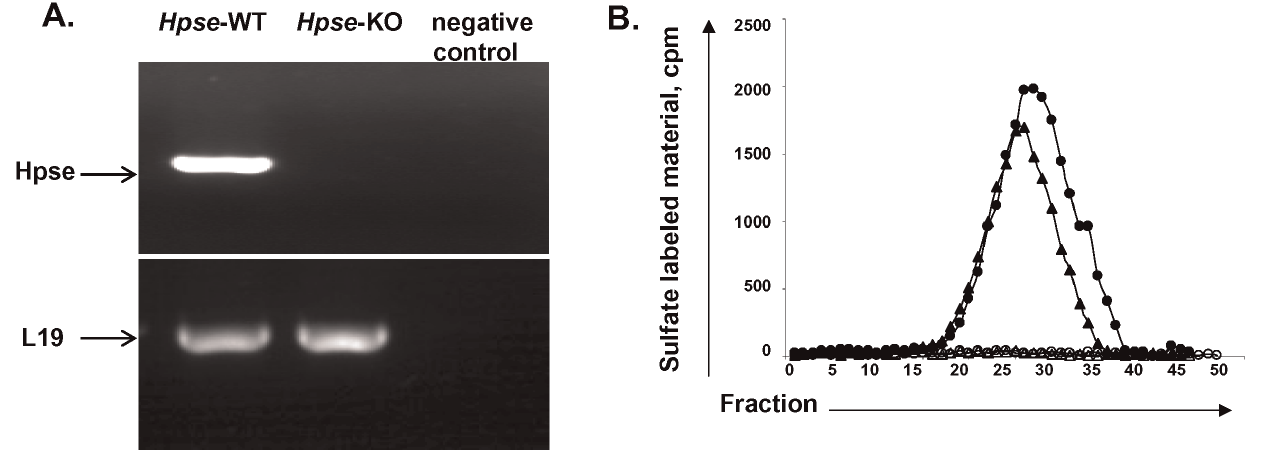
Figure 1. Heparanase is not expressed and not active in BMDCs from Hpse -KO mice. A . Heparanase RT-PCR. RNA was extracted from BMDCs of Hpse- WT and Hpse -KO mice. Primers specific for heparanase were used for RT-PCR (see Materials and Methods). Negative control represents RT-PCR without primer of heparanase. L-19 is shown for comparison. B . Heparanase Enzymatic Activity. Heparanase activity was determined in lysates of iBMDCs (closed circles) and mBMDCs (closed triangles) from Hpse- WT, and iBMDCs (opened circles) and mBMDCs (opened triangles) from Hpse -KO mice. Low-molecular-weight labeled degradation fragments eluted toward the V t of the column (peak II, fractions 15–30, 0.5 , K av , 0.75) were previously shown to be fragments of heparan sulfate. In contrast, sulfate-labeled material released from ECM by proteolytic enzymes or nondegraded heparan sulfate is of much higher molecular weight, and eluted next to the void volume (peak I, fractions two-eight).The data shown are representative of three experiments.